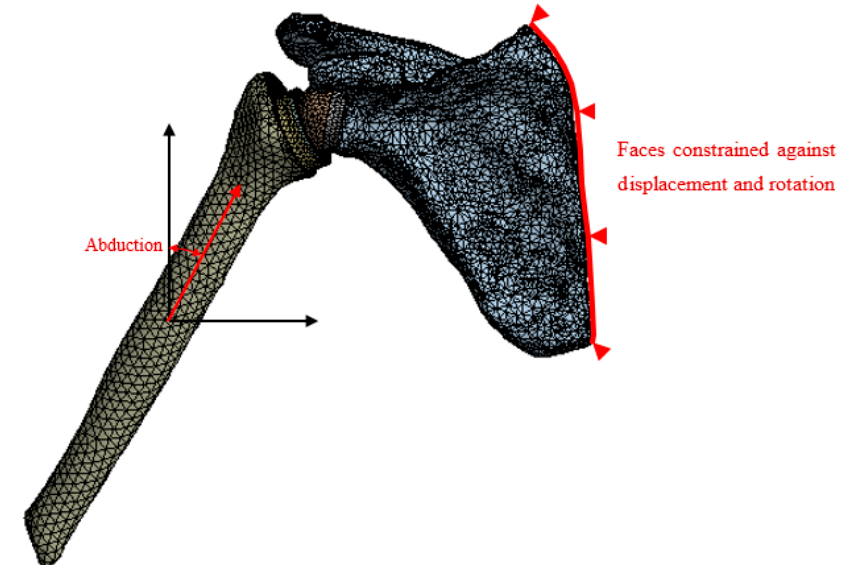
Figure 6. Illustration of the direction of the abduction force as a function of the angle of abduction and the fixed faces of the scapula.